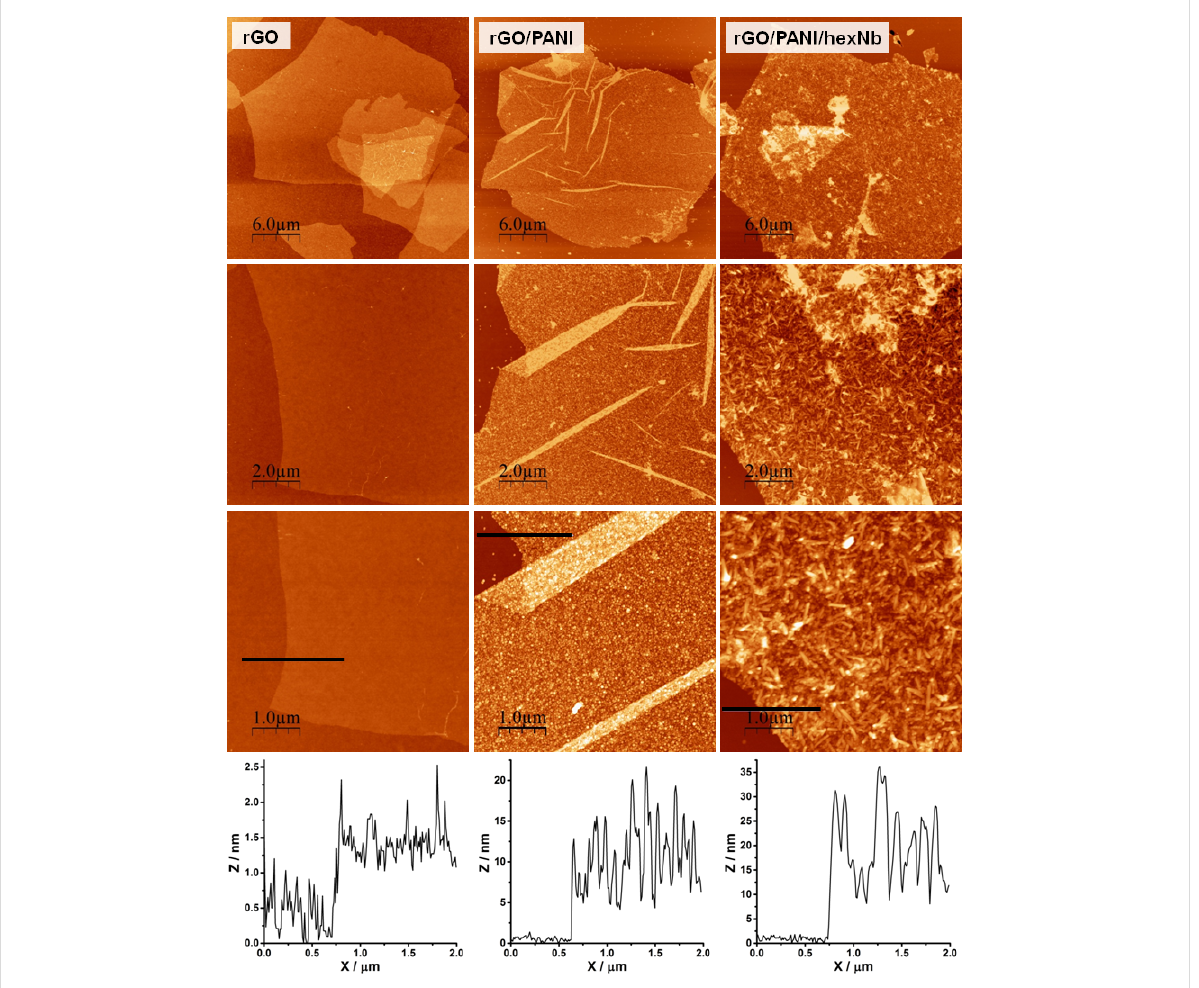
Figure 2: AFM images of rGO-25 sample, and rGO/PANI and rGO/PANI/hexNb nanocomposites at different scan sizes (30, 10 and 5 μ m), and height profiles (for the 5 μ m scan size images).